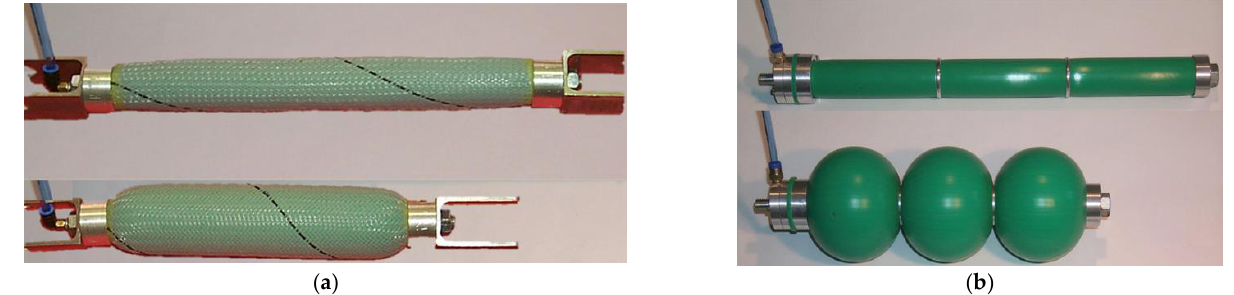
Figure 1. Rest and deformed configurations of: ( a ) McKibben muscle; ( b ) straight-fibers muscle.